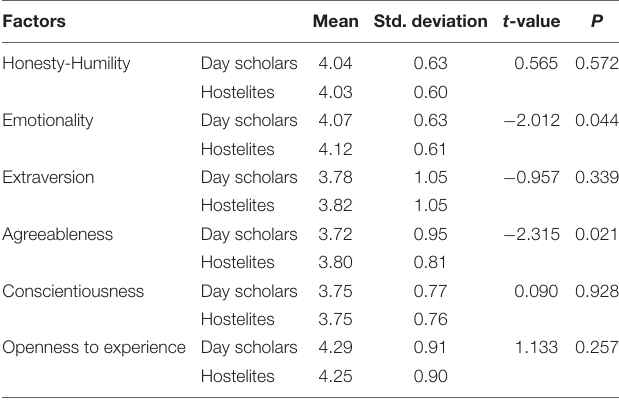
TABLE 7 | Comparison between hostelites and day’s scholar higher achievers’ students’ personality traits. Factors